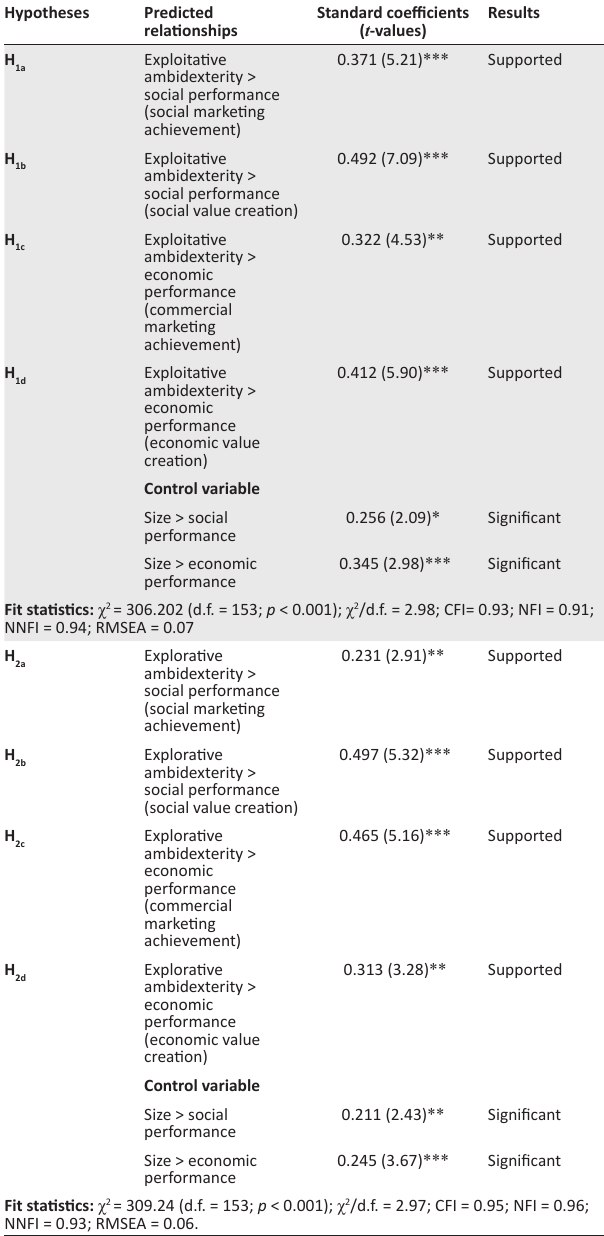
TABLE 3: The outcome of hypotheses test. Hypotheses Predicted Standard coefficients relationships ( t -values)